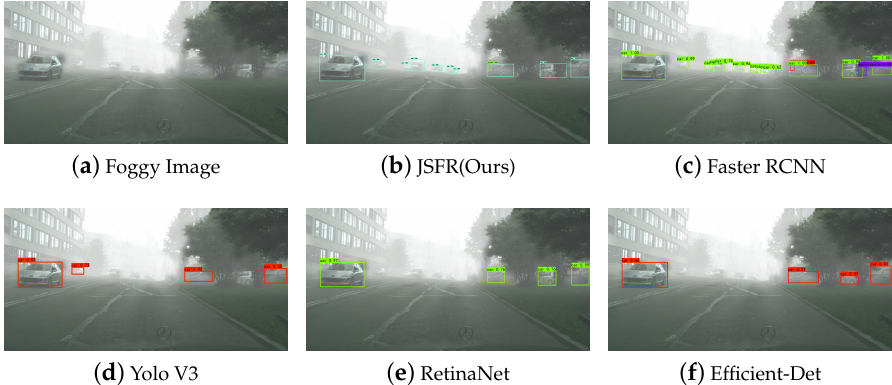
Figure 7. Testing results of JSFU and object detection methods including Faster RCNN , Yolo V3 , RetinaNet and Efficient-Det on Foggy Cityscapes with dense fog (electronic zoom-in